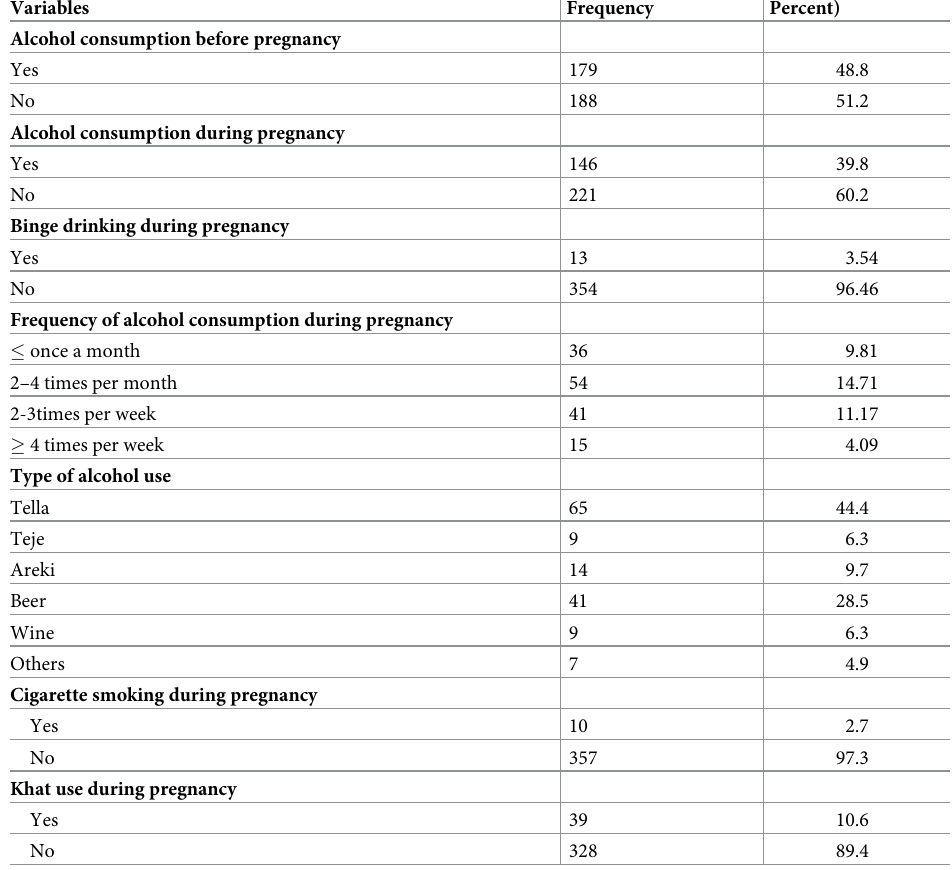
Table 3. Alcohol consumption and binge drinking among pregnant women in kolfe sub city (n = 367), Addis Ababa, Ethiopia.